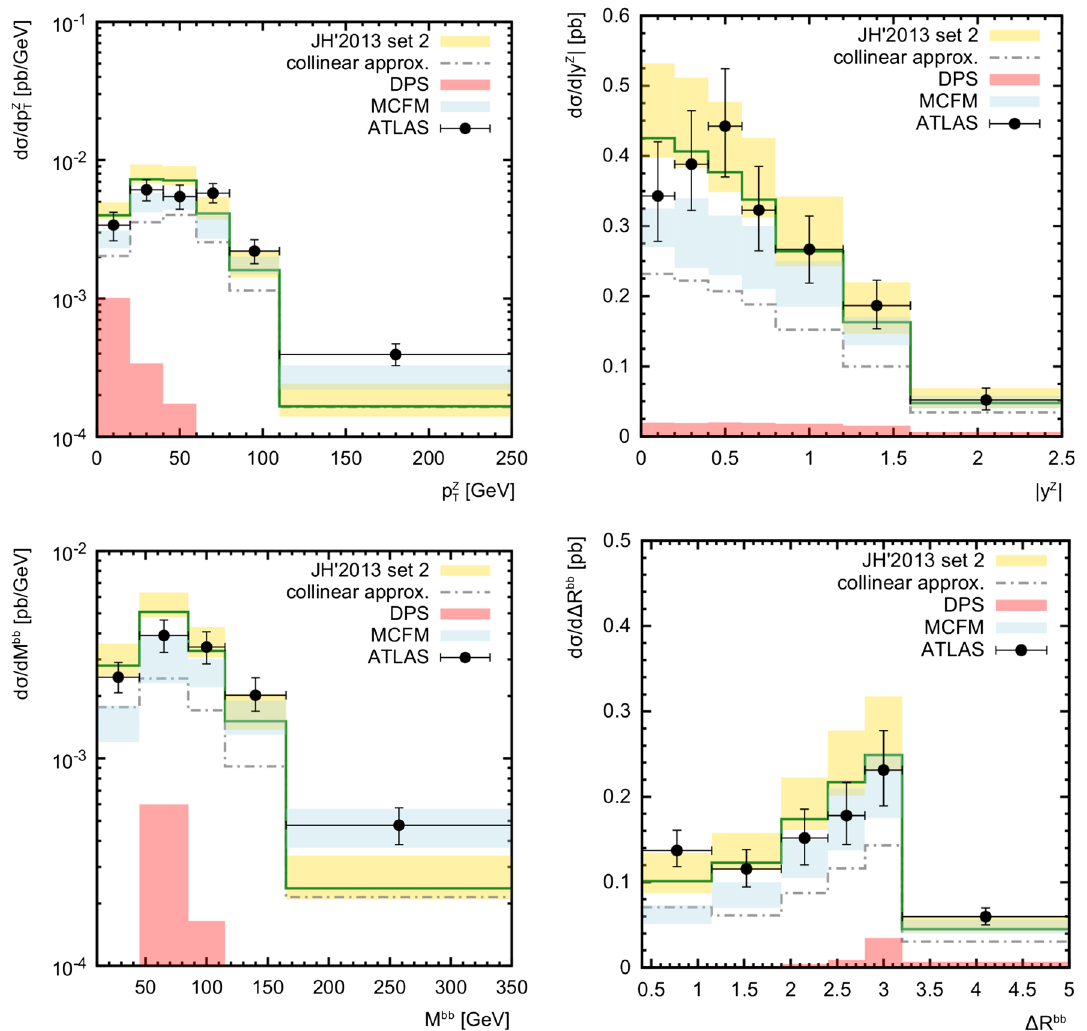
Fig. 3 Associated production of a Z boson with two beauty jets at √ s = 7 TeV calculated as a function of the Z boson transverse momen- tum, rapidity, invariant mass of the b -jet pair and angular separation